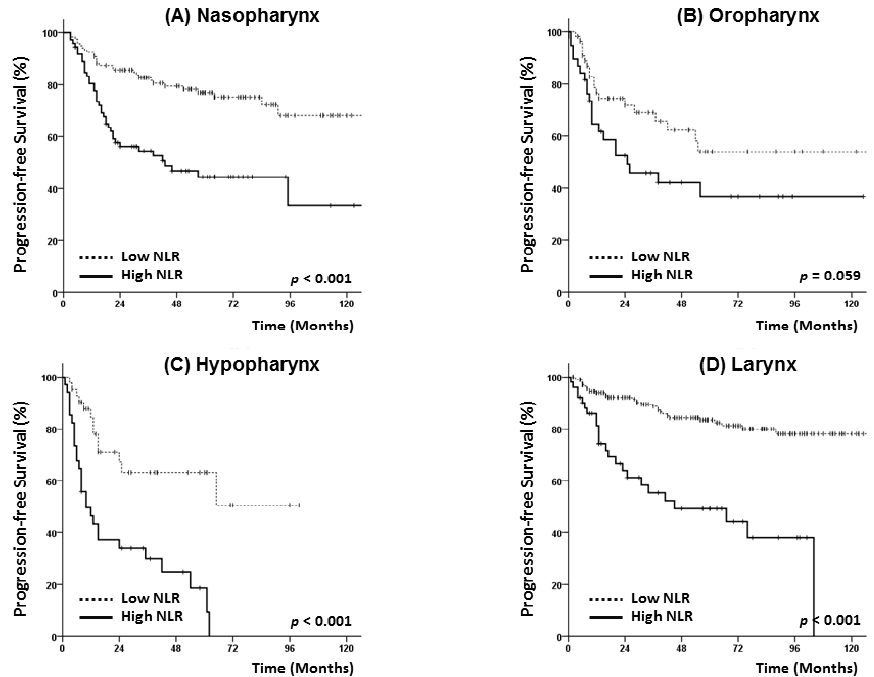
Figure 3. Subgroup analysis of progression-free survival according to primary tumor site: Nasopharynx ( A ), oropharynx ( B ), hypopharynx ( C ) and larynx ( D ).